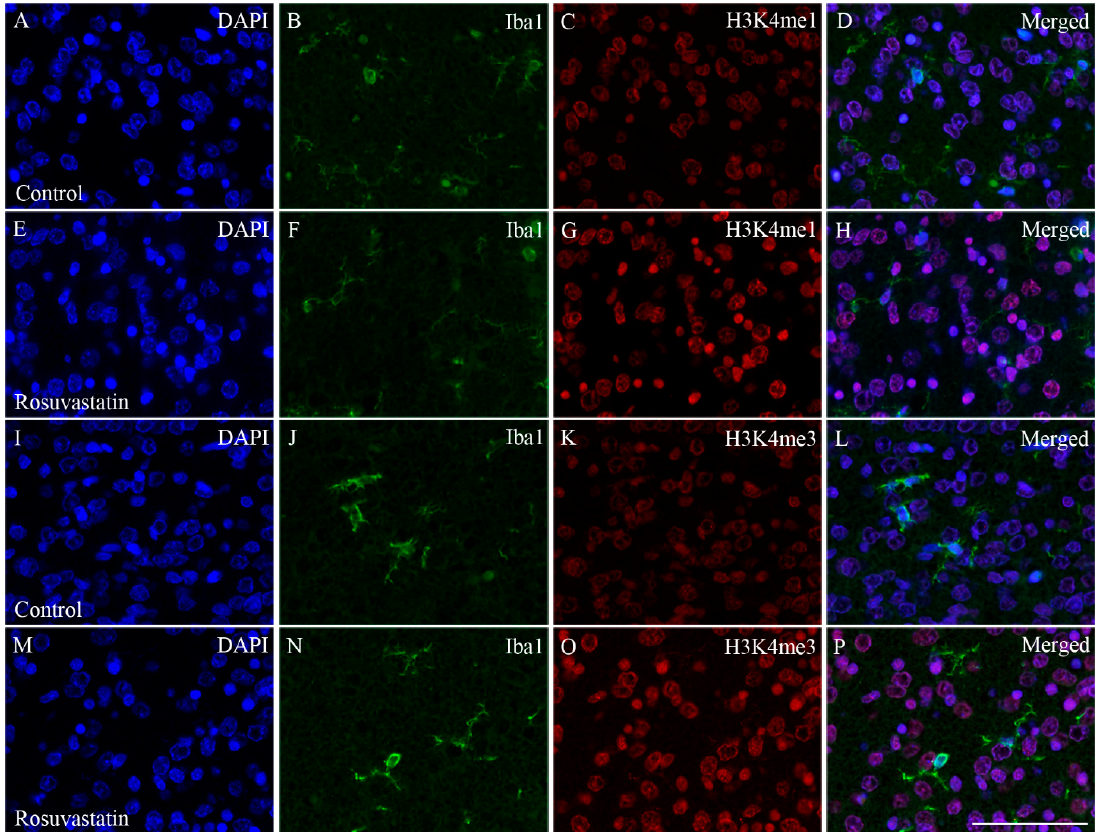
Figure 9. Colocalization of H3K4 methylation patterns and Iba1 immunoreactivity in the microglial cells of the newborn brain. In a newborn rat brain, the majority of the cells are neurons. At birth, microglia are unevenly distributed and located in specific “hotspots” such as the ventricular zone. Due to their overwhelmingly neuronal localization, H3K4me1 and H3K4me3 immunoreactivities (shown here in red) were more intense in the sections cut from the RST-treated newborns ( E – H , M – P ) as compared to the controls ( A – D , I – L ). A few H3K4 methylated cell nuclei belonged to Iba1-positive microglia (shown here in green). DAPI-labeled nuclei are shown in blue ( A , E , I , M ). Scale: 75 µm.